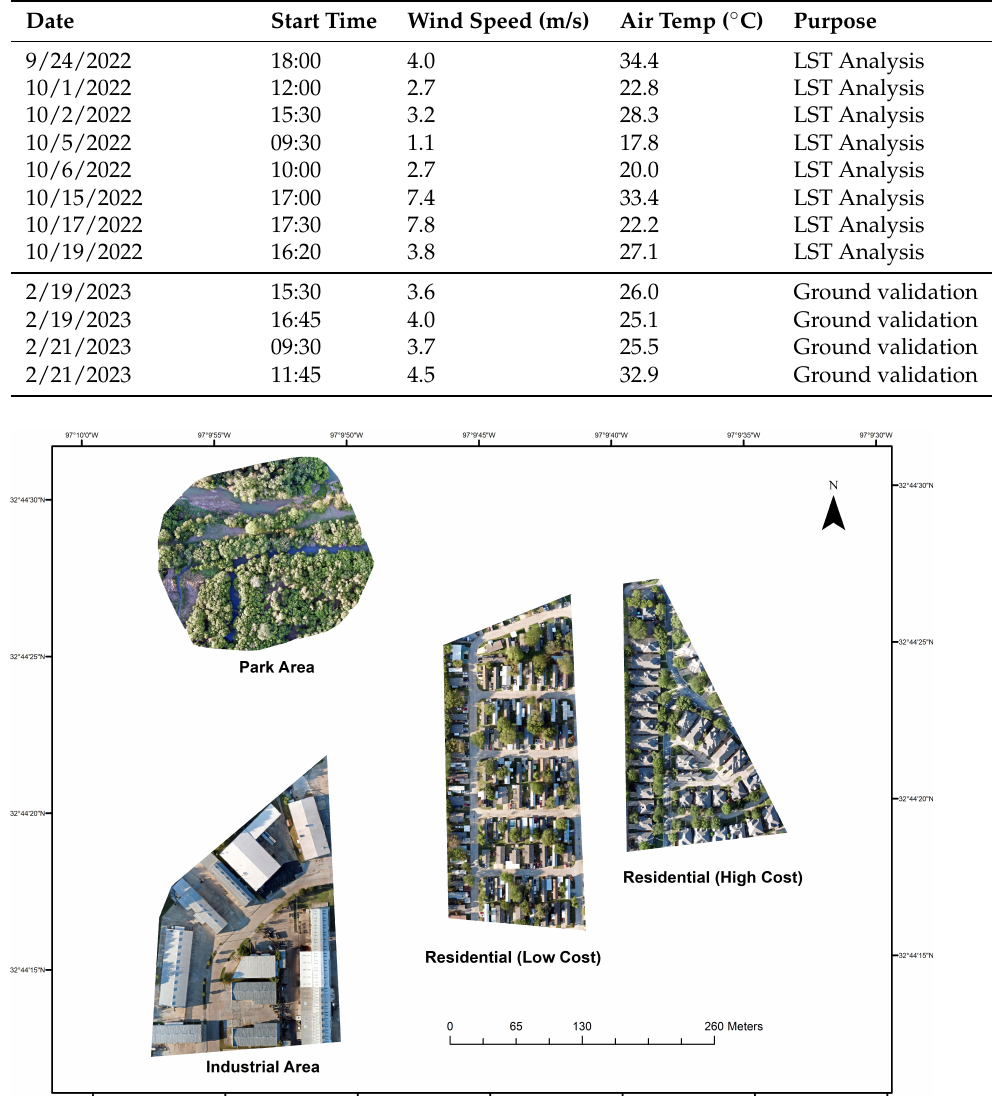
Table 2. Flight details with average wind speed and air temperature.